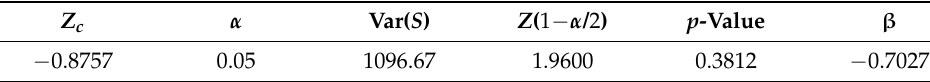
Table 5. Mann–Kendall test and Sen’s slope estimator.